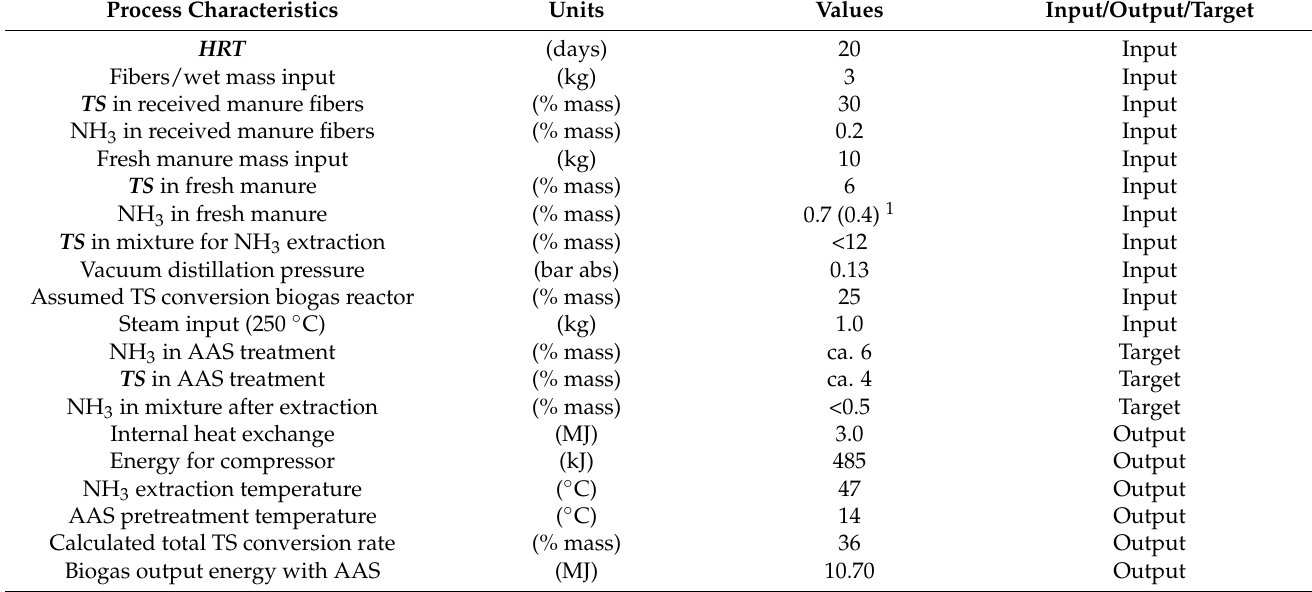
Table 5. Input/output/target conditions for modeling in